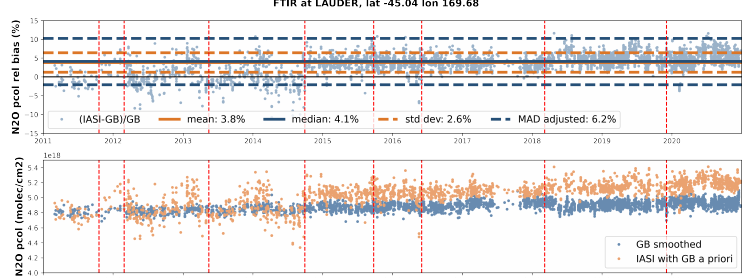
Figure 16. Validation time series at the NDACC Lauder station: time series of ( top ) relative bias of the averaged co-located IASI data and ( bottom ) IASI adjusted N 2 O partial columns ( pcol IASI , adj ) and ground-based (GB) smoothed partial columns ( pcol NDACC , regr , sm ). Statistics of the comparisons are also shown: mean and median bias, standard deviation of the bias and median of absolute deviations (MAD) adjusted to correspond to the standard deviation of a Gaussian distribution (multiplied by 1.4826). Dotted red vertical lines represent the changes in the EUMETSAT IASI level 2 processor version listed in Table 1, and in addition the 16 May 2013 when an update in the EUMETSAT operational level1 processing occurred [76].